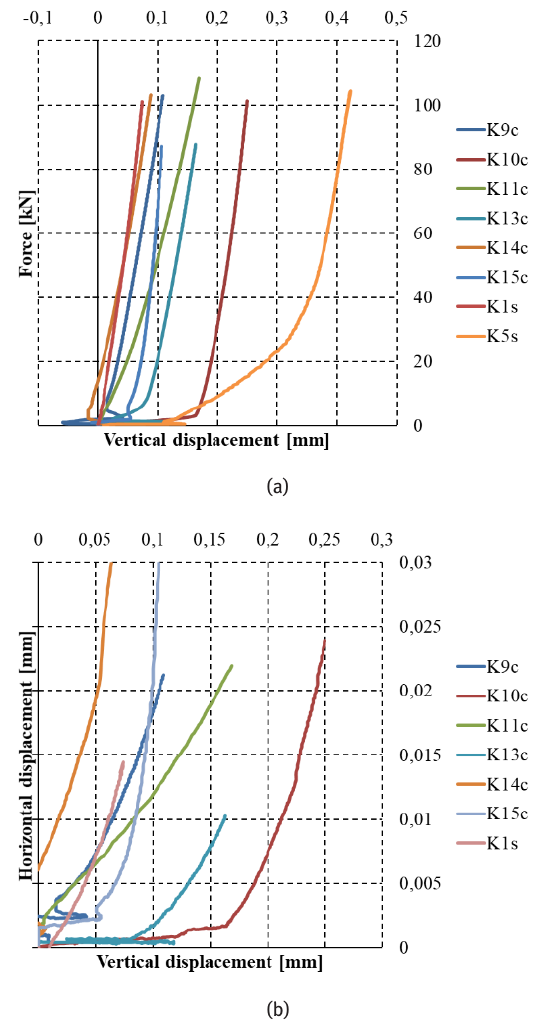
Figure 5: Results of the compressive tests: a) relation between the force and vertical displacement, b) relation between horizontal and vertical